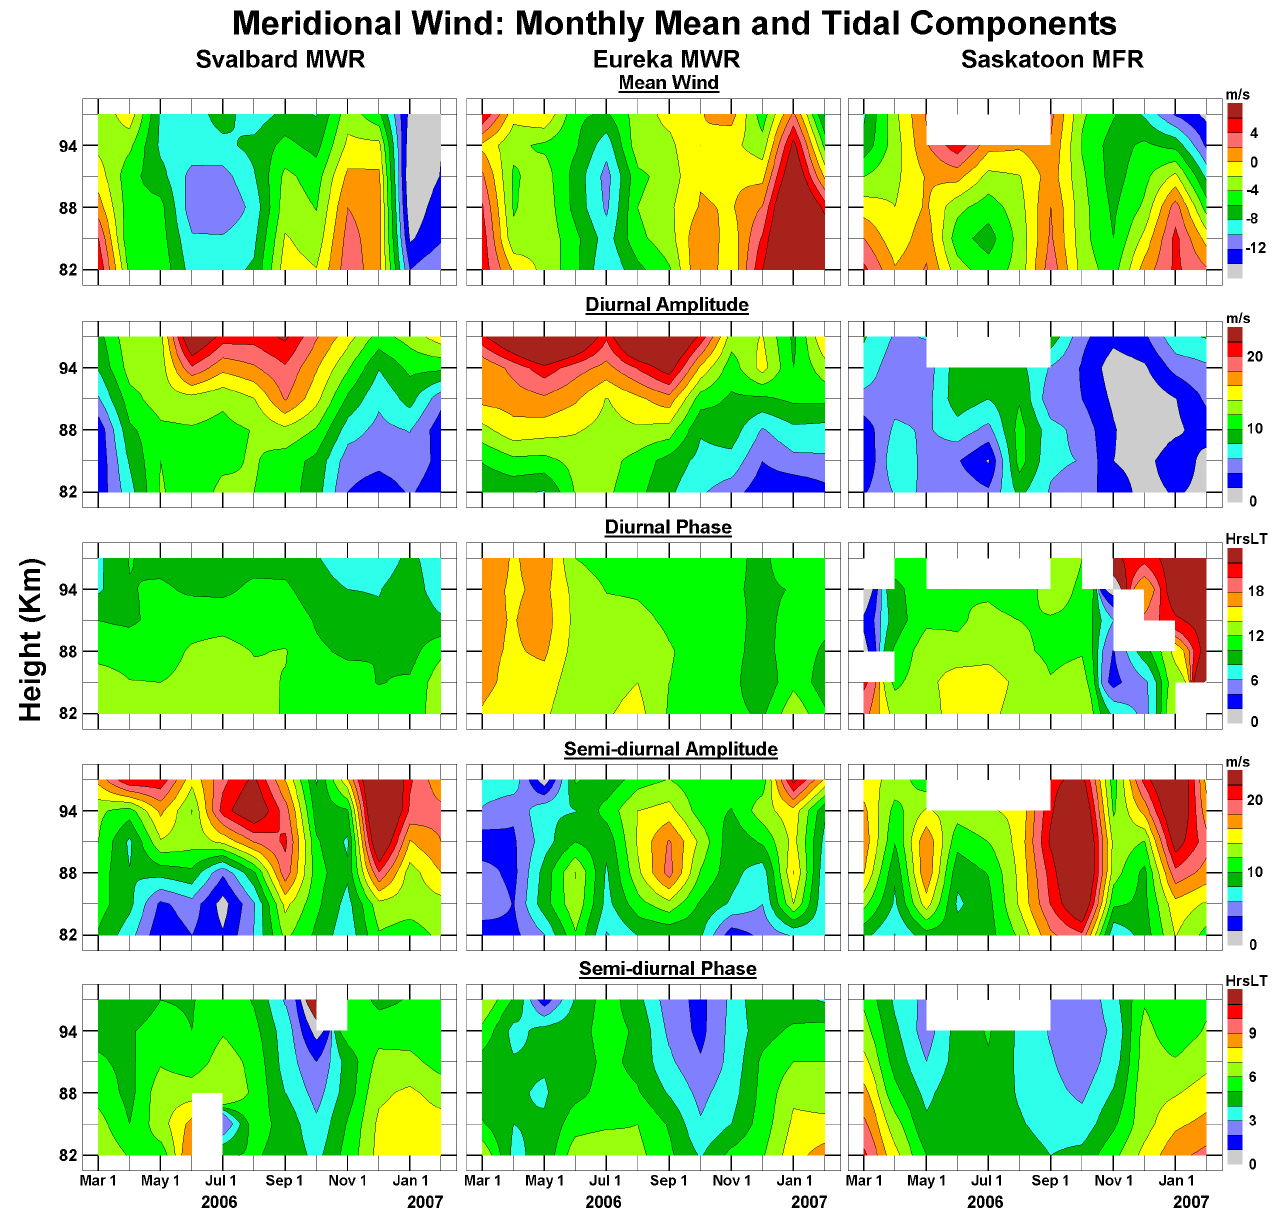
Fig. 5. Meridional winds for mean background winds and the tides, both diurnal (24-h) and semidiurnal (12-h). Northward tidal winds are taken as positive, and the phases are the local solar times of maximum northward winds. Heights above 94km in mid-summer at Saskatoon are judged to be above the heights of total reflection for the MFR and therefore are not